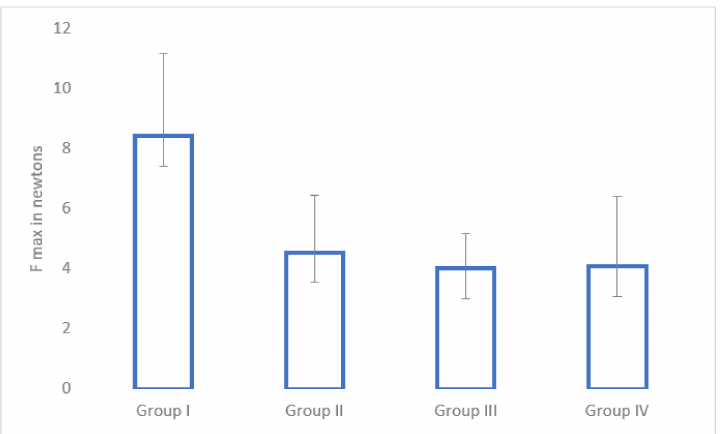
Figure 5. Mechanical pull-put test in Group I (control), Group II (enoxaparin), Group III (nadroparin) and Group IV